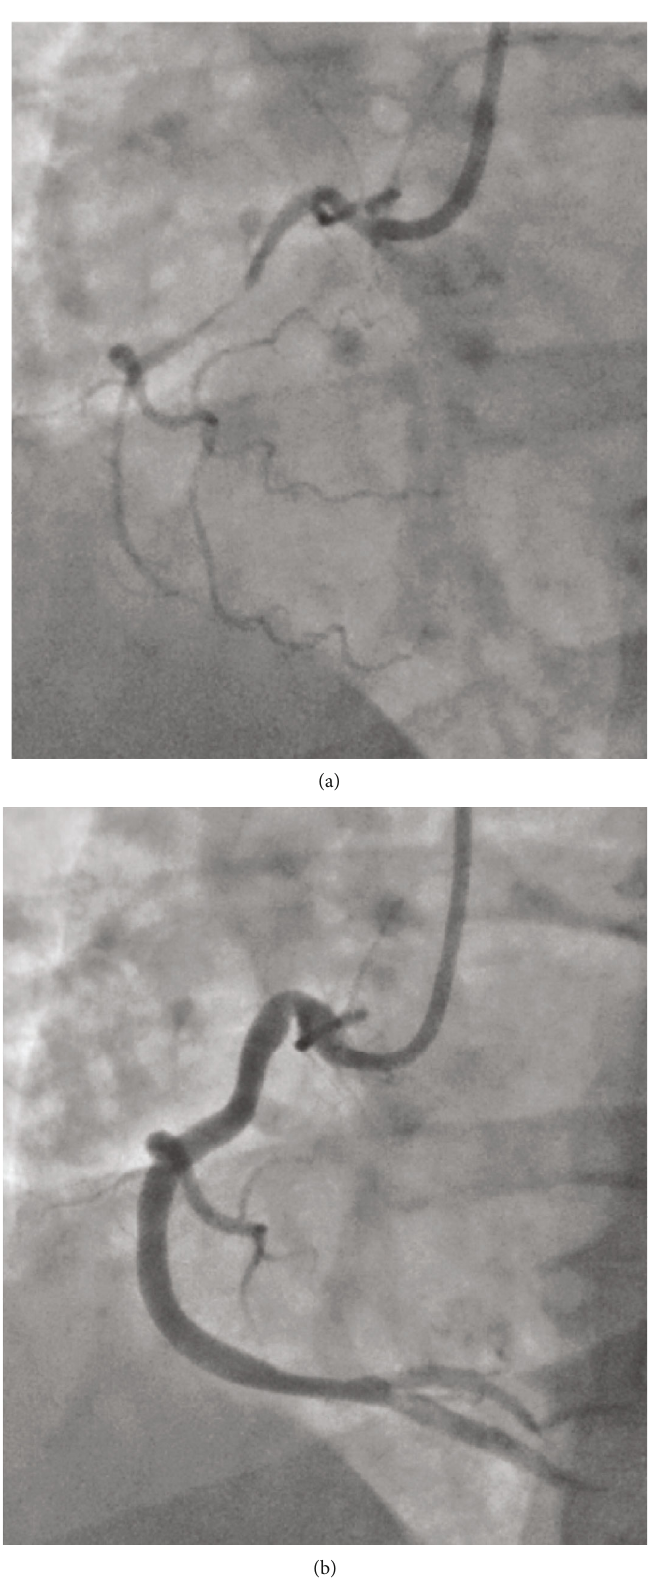
Figure 2: ‘ Right coronary artery: before and after. ’ This fi gure is a coronary angiogram containing 2 images (a, b). (a) Narrowing of the right coronary artery shortly after cardiac arrest. (b) How the narrowing of the same right coronary artery was almost completely restored immediately after administration of 400 micrograms of intracoronary